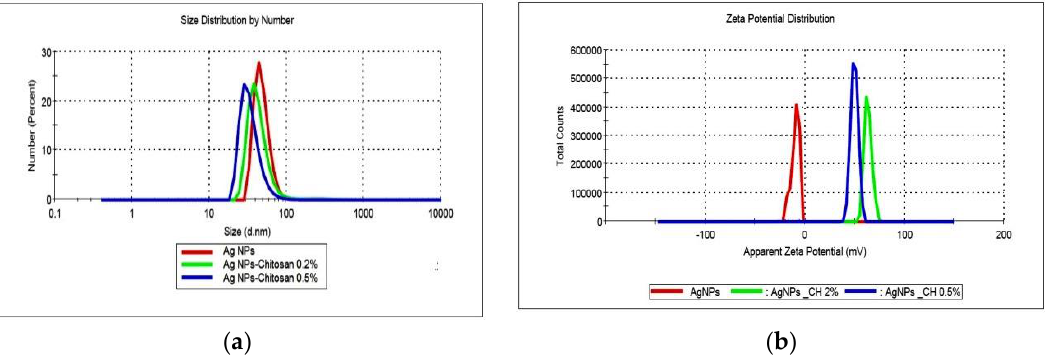
Figure 3. ( a ) The size and size distribution of AgNPs stabilized with high molar weight (HMW) chitosan solution; ( b ) Zeta potential of the same samples.